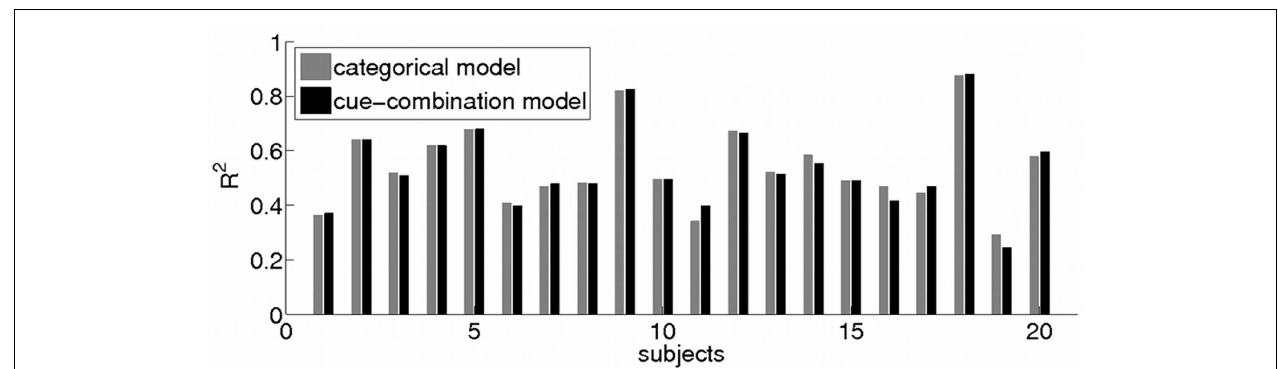
FIGURE 7 | Model Comparison. Bar plot of individual R 2 values of the model fit for the categorical (gray) and cue-combination model (black) to each subjects’ behavior (1–20) in the IR-C condition. A comparison of the goodness of fit of the categorical and the cue-combination model revealed no significant difference between the two